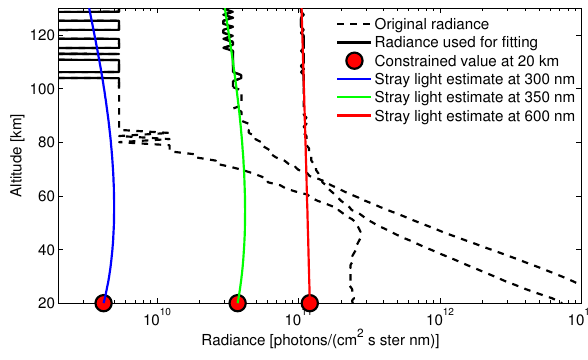
Fig. 2. Stray light estimation for 300nm, 350nm, and 600nm. The spectral shape of the stray light is used to calculate the 20km points (red circles), which are then used together with the > 100km radi- ance values to calculate the stray light estimates for all